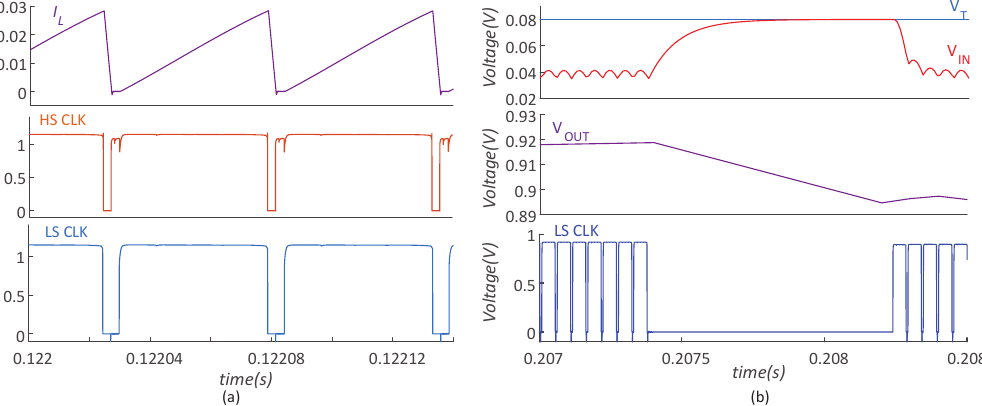
Figure 13. ( a ) The simulation results with V T of 128 mV with 600 µ A load; ( b ) the sample